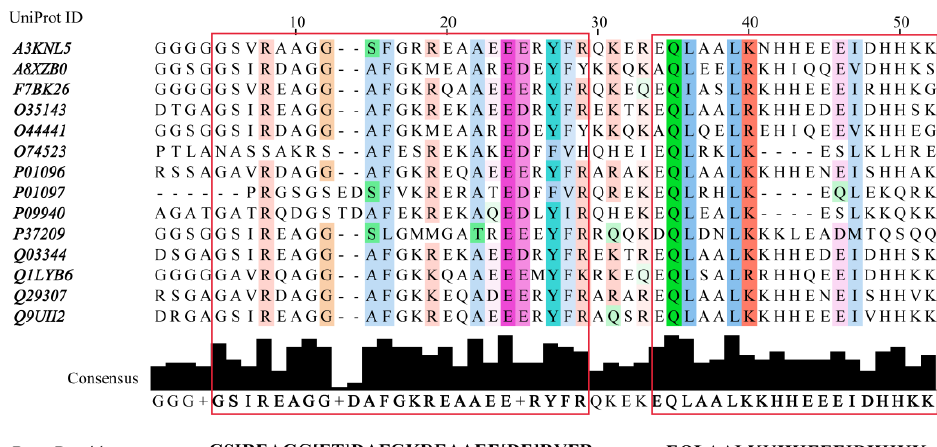
Figure 4. Multiple Sequence Alignment (MSA) performed with Multiple Alignment using Fast Fourier Transform, MAFFT, [55] for IF1 inhibitors deposited in the UniProt database. Consensus regions are identified at >40% of identity threshold at each position of the MSA. The resulting consensus regions are framed in a rectangular box. From them two root peptides were estimated IF1 sources: A3RKNL5, zebrafish. A8XZB0, Caenorhabditis briggsae. F7BK26, western clawed frog. O35143, mouse. O44441, Caenorhabditis elegans. 074523, fission yeast. P01096, bovine. P01097, baker’s yeast. P09940, torula yeast. P37209, Caenorhabditis elegans. Q03344, rat. Q1LYB06, zebrafish. Q29307, pig. Q9UII2, human. Jalview ver: 2.11.1.4 was used to visualize the MSA and determine the consensus.